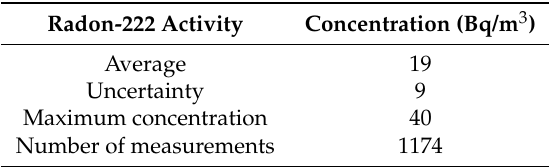
Table 4. Concentration after air conditioning installation.